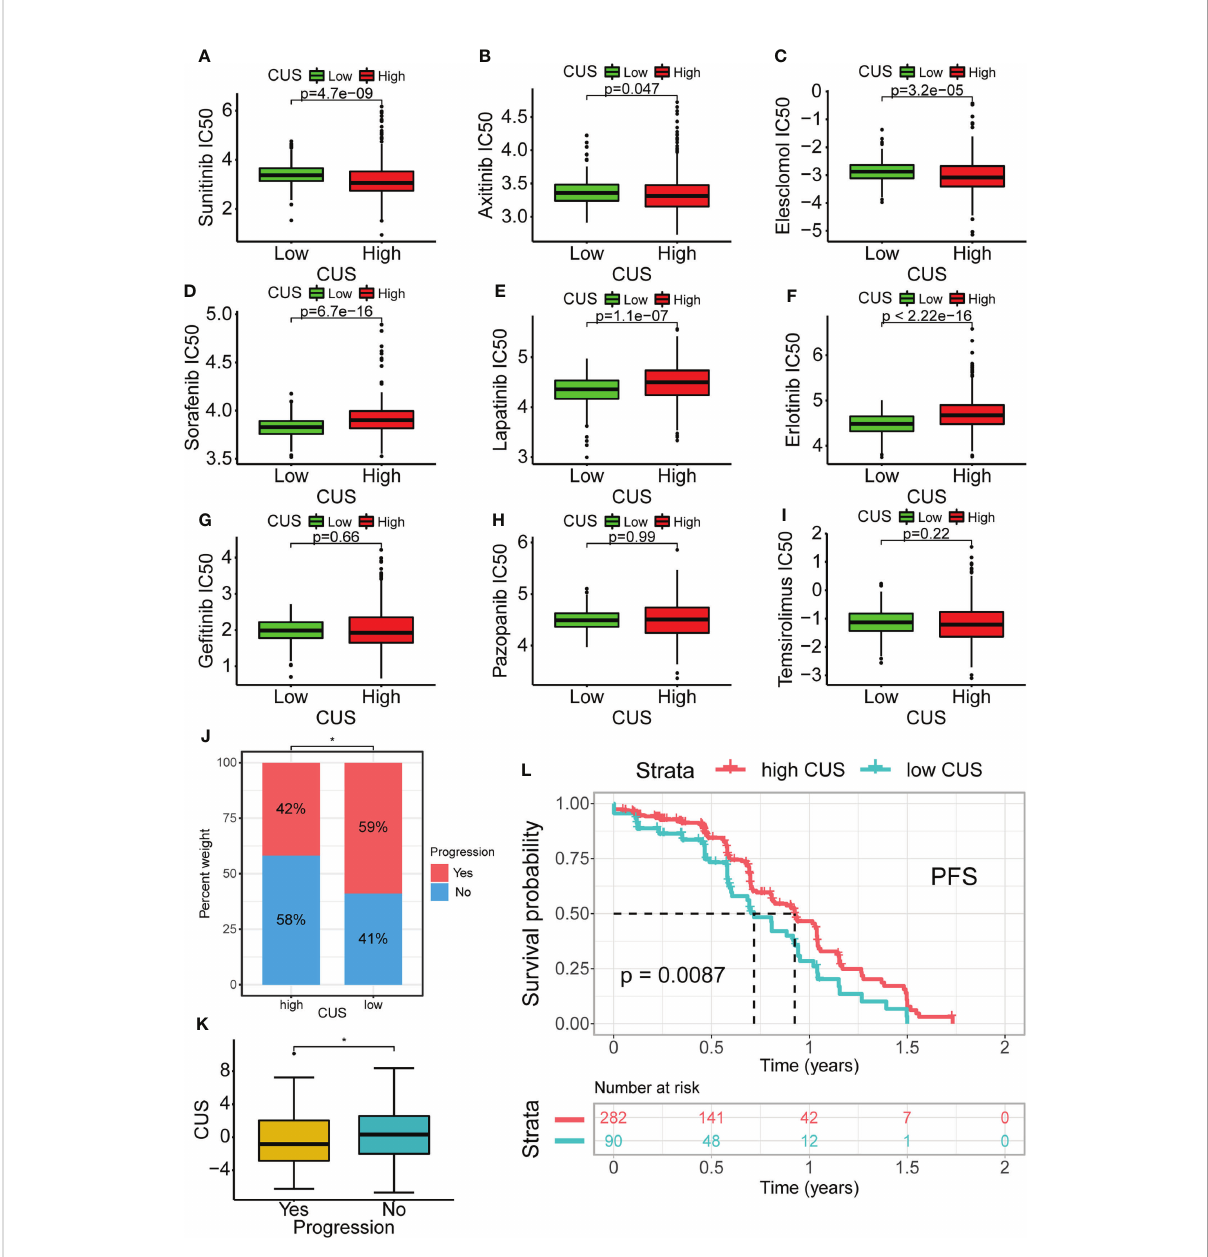
FIGURE 9 Drug susceptibility analysis of common targeted drugs and validation of targeted therapy cohort in KIRC. Based on cuproptosis grouping, drug sensitivity of Sunitinib (A) , Axitinib (B) , Elesclomol (C) , Sorafenib (D) , Lapatinib (E) , Erlotinib (F) , Ge fi tinib (G) , Pazopanib (H) and Temsirolimus (I) is conducted. (J) Obtaining data from the KIRC cohort using Sunitinib in NCT02684006. Proportional distribution of progression status in the high- and low-CUS groups. (K) Comparison of CUS levels between progression group and non-progression group. (L) Kaplan – Meier survival analysis between the high- and low- CUS groups (PFS, Log-rank test, p < 0.001). CUS, cuproptosis score; PFS: progression free survival; *p <